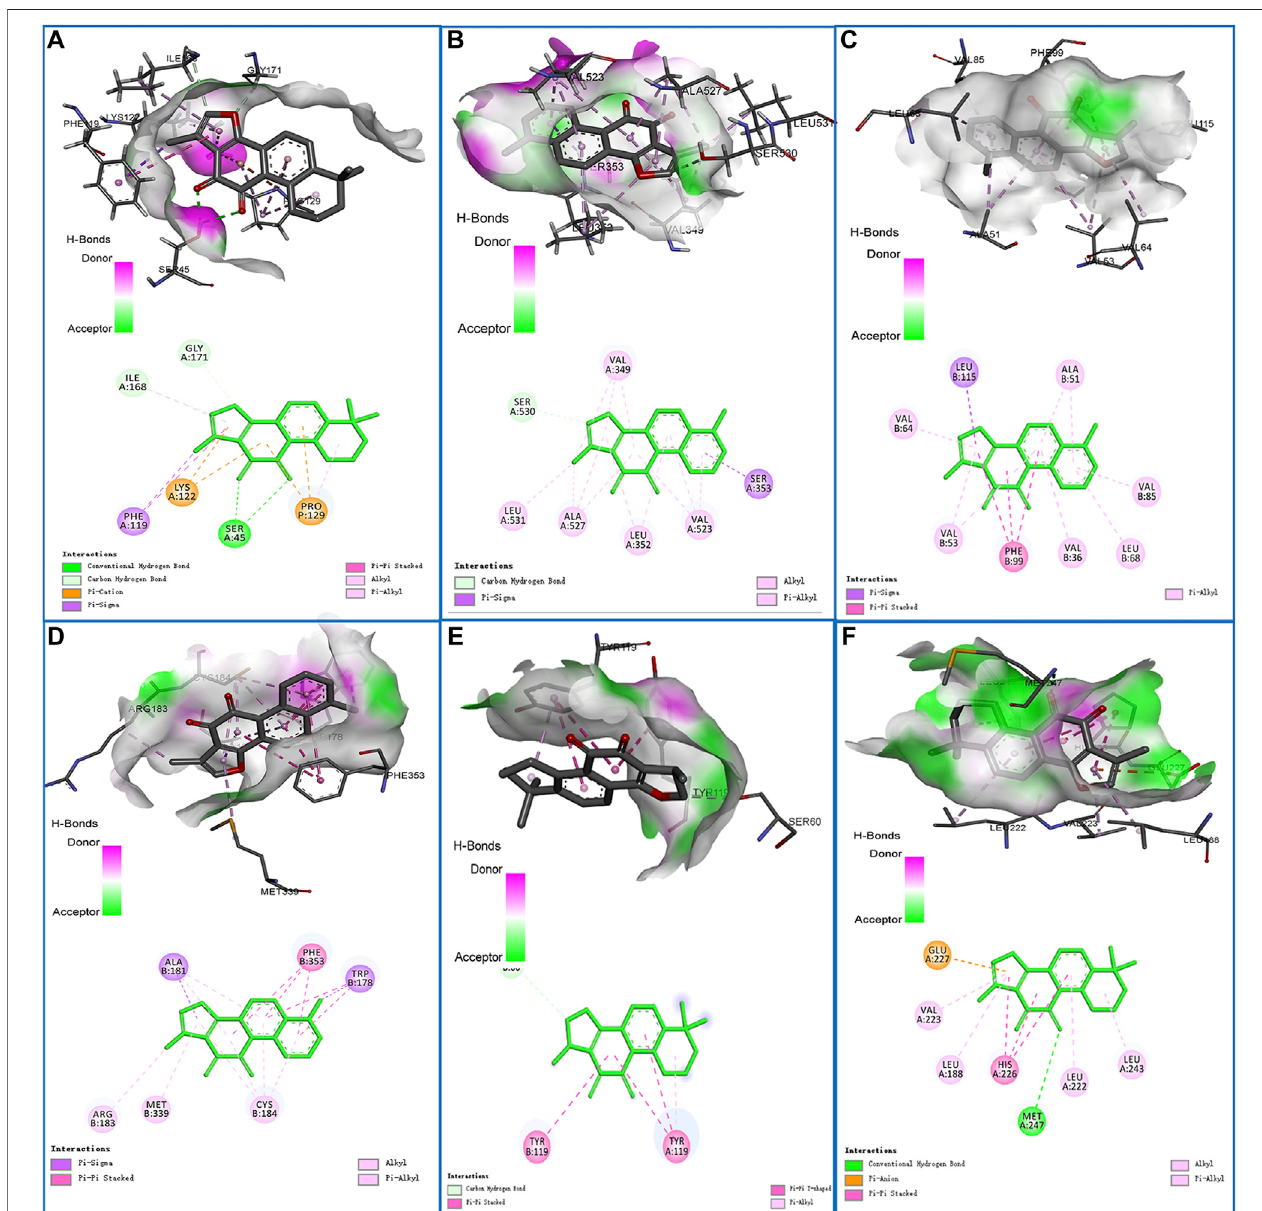
FIGURE 7 | Schematic diagrams (3D and 2D) of the binding modes of representative component-targets. (A) Tanshinone IIA with RELA; (B) Tanshinone I with PTGS2; (C) Tanshinone I with VEGFA; (D) Tanshinone I with NOS3; (E) Tanshinone IIA with MMP9; (F) Cryptotanshinone with TNF.